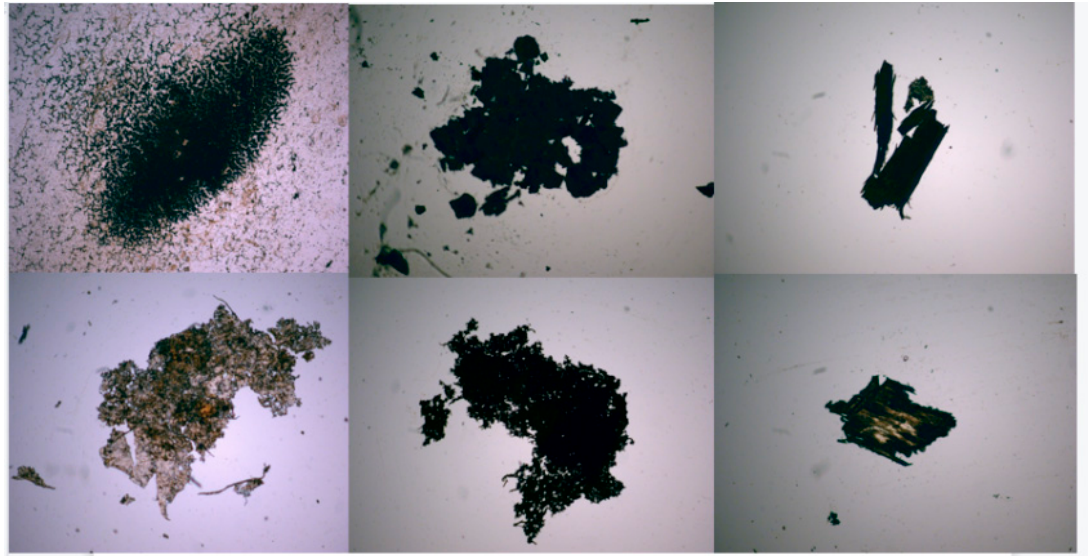
Figure 3. Shape and size of PFs observed using an electron microscope.